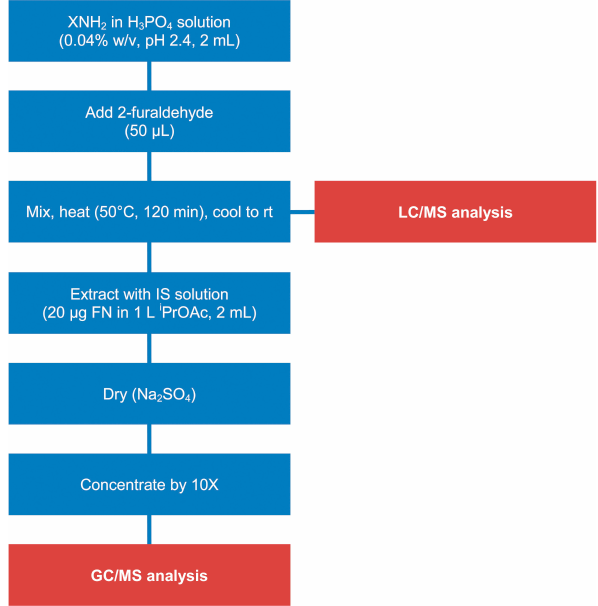
Fig. 5. Flowchart summary of the X-NH 2 derivatization proce- dure. H 3 PO 4 , phosphorous acid; IS, internal standard; FN, 1- fluoronaphthalene; i PrOAc, iso -propyl acetate; Na 2 SO 4 , sodium